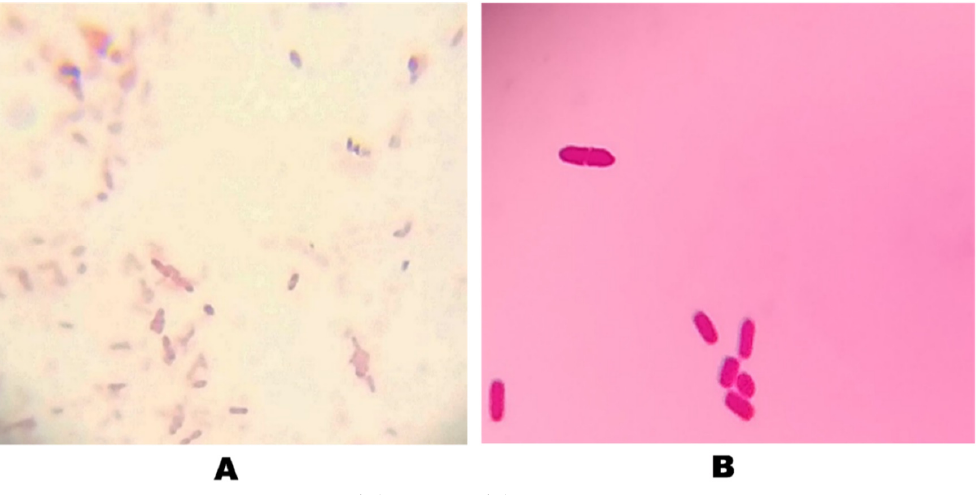
Figure 4. Gram staining view of PKI7 (A) and PKI8 (B) Table 2 summarises the morphological and biochemical properties of the isolates. Table 2. Morphological and biochemical characterization of bacterial